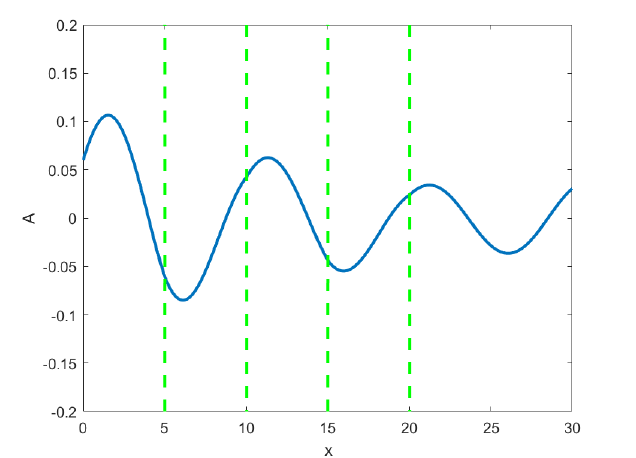
Figure 4. Numerical Simulation of the Wave Propagation Phenomenon with Friction-Factor.